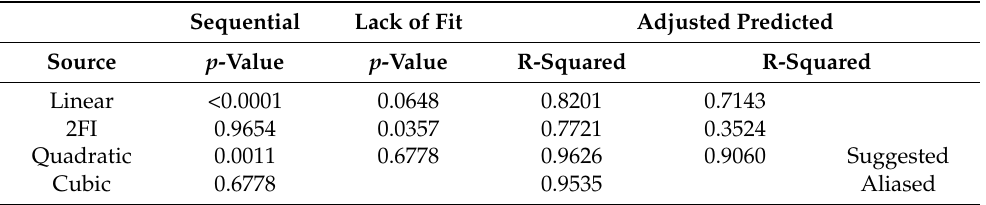
Table 6. Calculation of fitted equations.